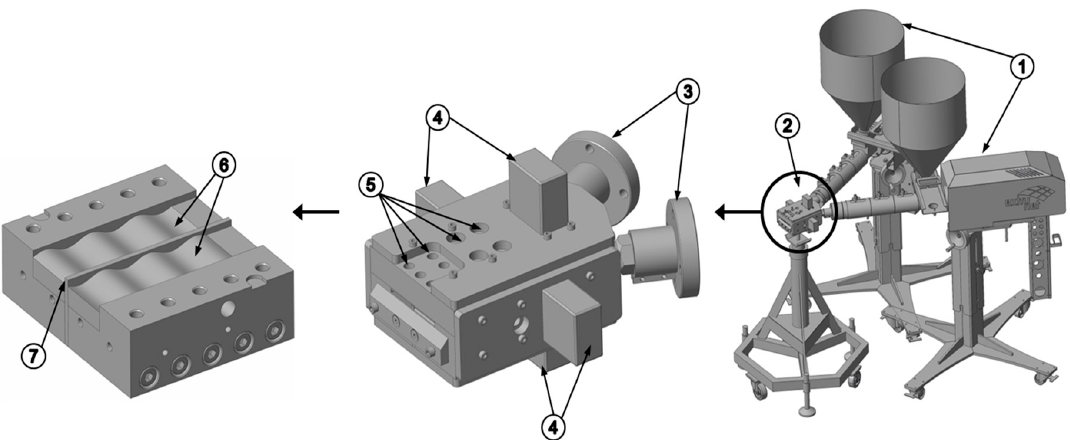
Figure 4. Components of the test device: ( 1 ) single-screw extruders; ( 2 ) extrusion die; ( 3 ) adaptors; ( 4 ) heating plates; ( 5 ) holes for measurement device; ( 6 ) sinusoidal flow channels; and ( 7 ) barrier flight. Two ece-30 single-screw extruders (Extrunet, Kremsmuenster, Austria) equipped with a standard extruder screw of outer diameter D b = 30 mm and axial length L = 606 mm (20.2 · D b ) were employed to